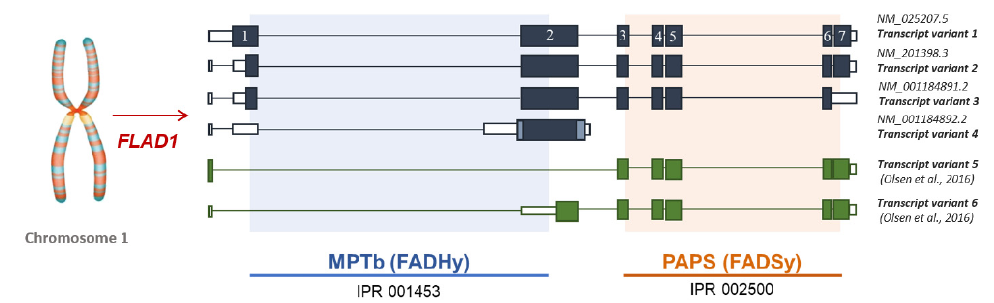
Figure 3. Sketch representation of FLAD1 transcript variants. In dark blue are indicated the four transcript variants reported in RefSeq whereas in green are indicated the two FLAD1 novel transcript variants as reported in [80]. Big colored boxes represent coding regions while lines represent introns. In transcript variant 4 light colored boxes represent di ff erent coding regions with respect to the transcript variant 1. The two functional domains of the longest isoforms are colored in the background. Homology modeling of the single domains are reported in